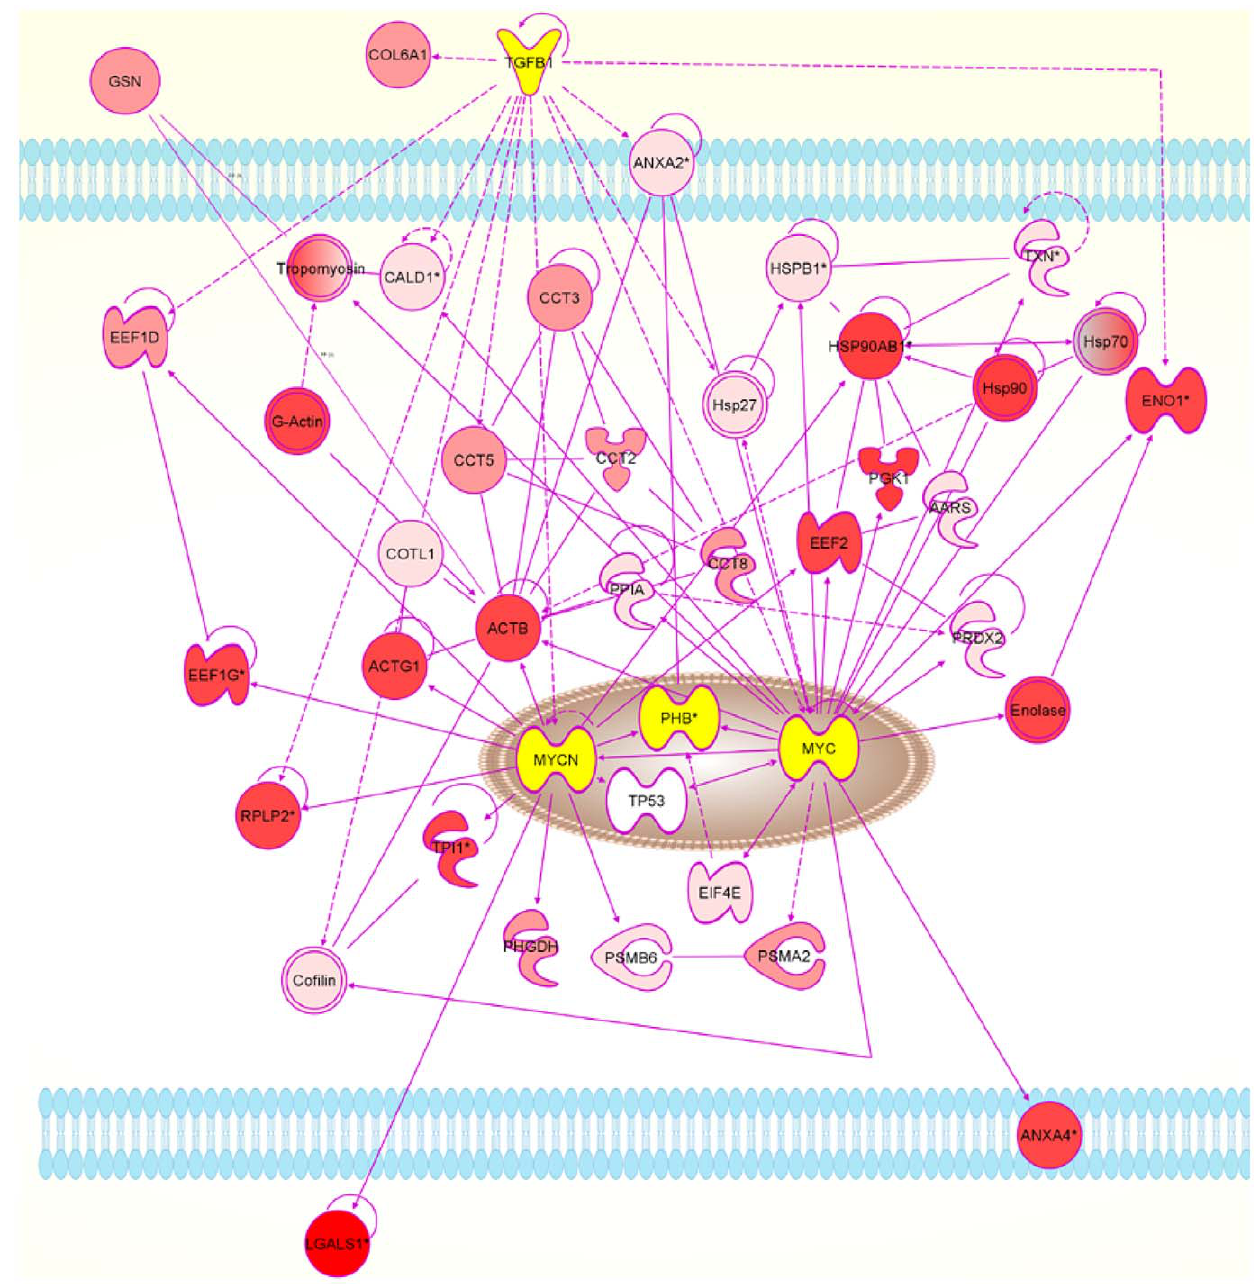
Figure 6. Network diagram for PP cells produced by IPA analysis. The diagram shows the possible interactions of LGALS1 with MYC and related transcription factors. PP cells, pedicle periosteum cells.